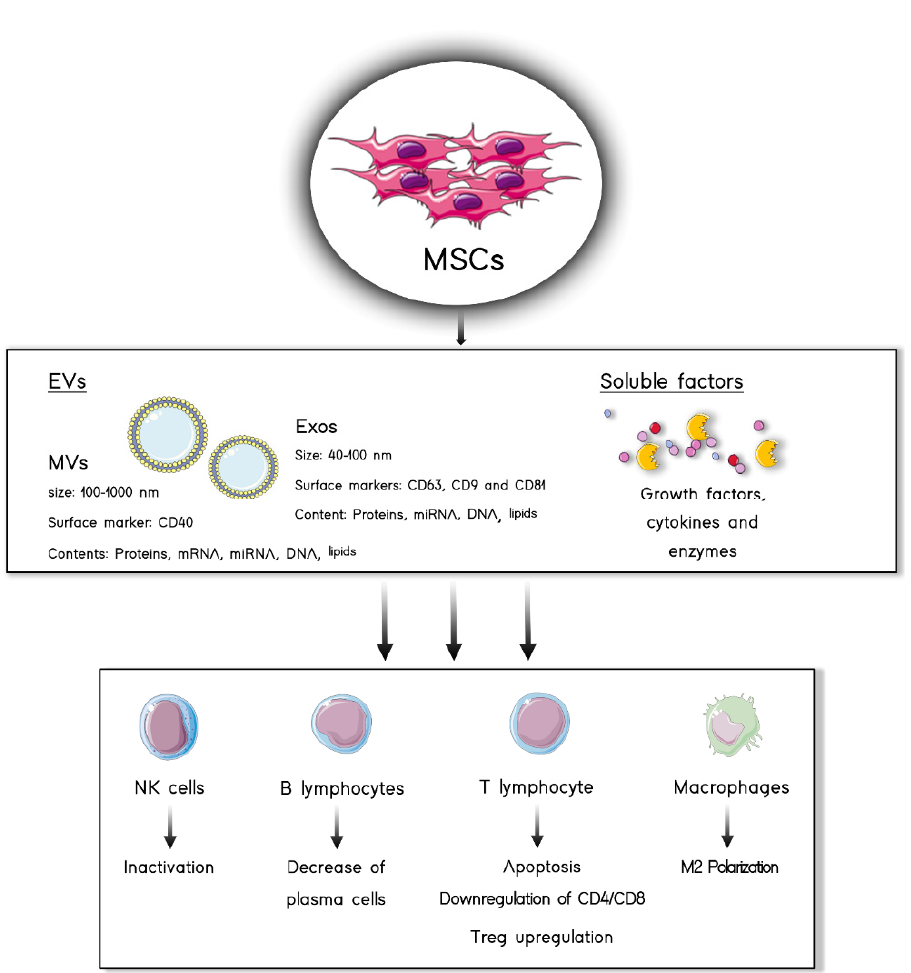
Figure 1. MSC secretome is composed of two different fractions: EVs and soluble factors. Both of them are capable of eliciting immunomodulatory effects on immune cells such as lymphocytes, macrophages and NK cells.